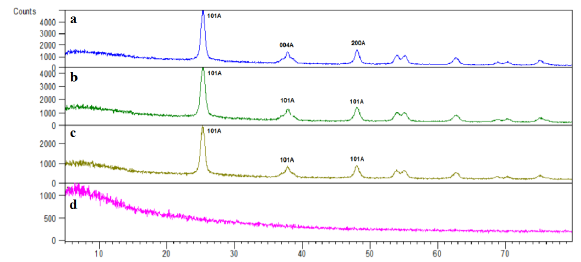
Figure 2. X-ray diffraction (XRD) spectrum from the surface of thin layer a: pure TiO powder, b: TiO coated on glass microbullets, c: 2 2